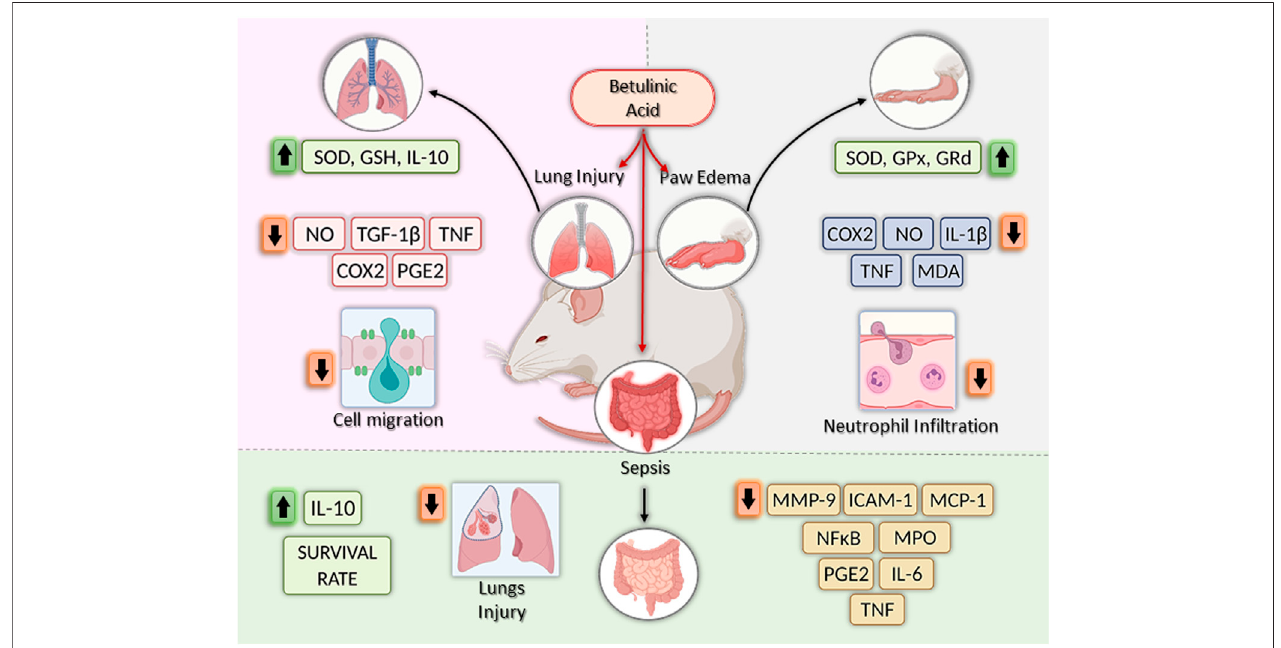
FIGURE 3 | Effects of betulinic acid in vivo models. Betulinic acid (BA) reduced lung in fl ammation by increasing levels of GSH, SOD and IL-10, by inhibiting the expression ofproin fl ammatorymediators, such asNO, TGF- β 1,TNF, COX-2, and PGE2,and byreducingcell migration tothelesion site. In thepaw edema models, BA treatmentincreasedtheactivitiesofantioxidantenzymes(SOD,GPxandGRd),reducedCOX-2,IL-1 β ,NO,TNF,MDA,andTNF,aswellasneutrophilin fi ltration,leading to the reduction of swelling in the paw. Finally, in sepsis models, BA treatment increase survival rate by decreasing levels of MMP-9, ICAM-1, MCP-1, PGE2, IL-6, and TNF, reducing lung injury and decreasing MPO and NF- κ B activity. In addition, increase IL-10 production. Created with